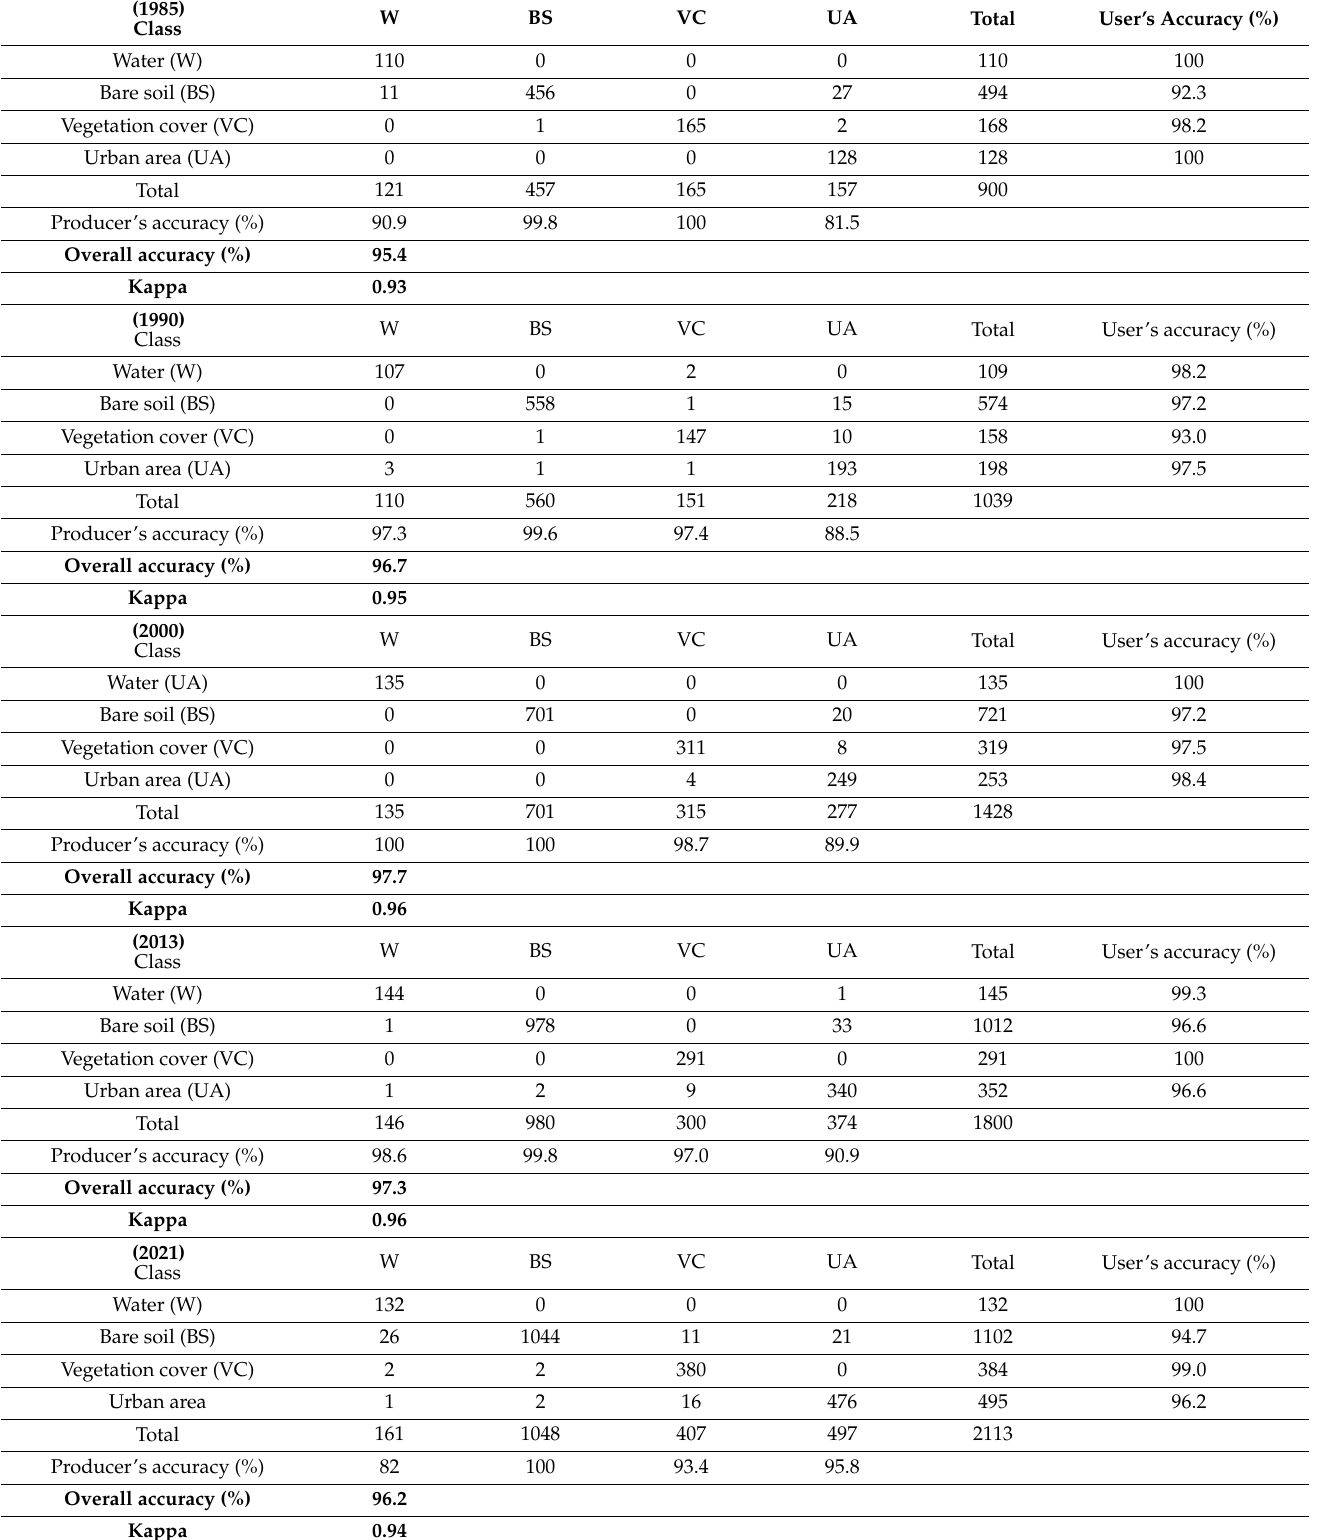
Table 2. Confusion matrices for 1985, 1990, 2000, 2013, and 2021 classified